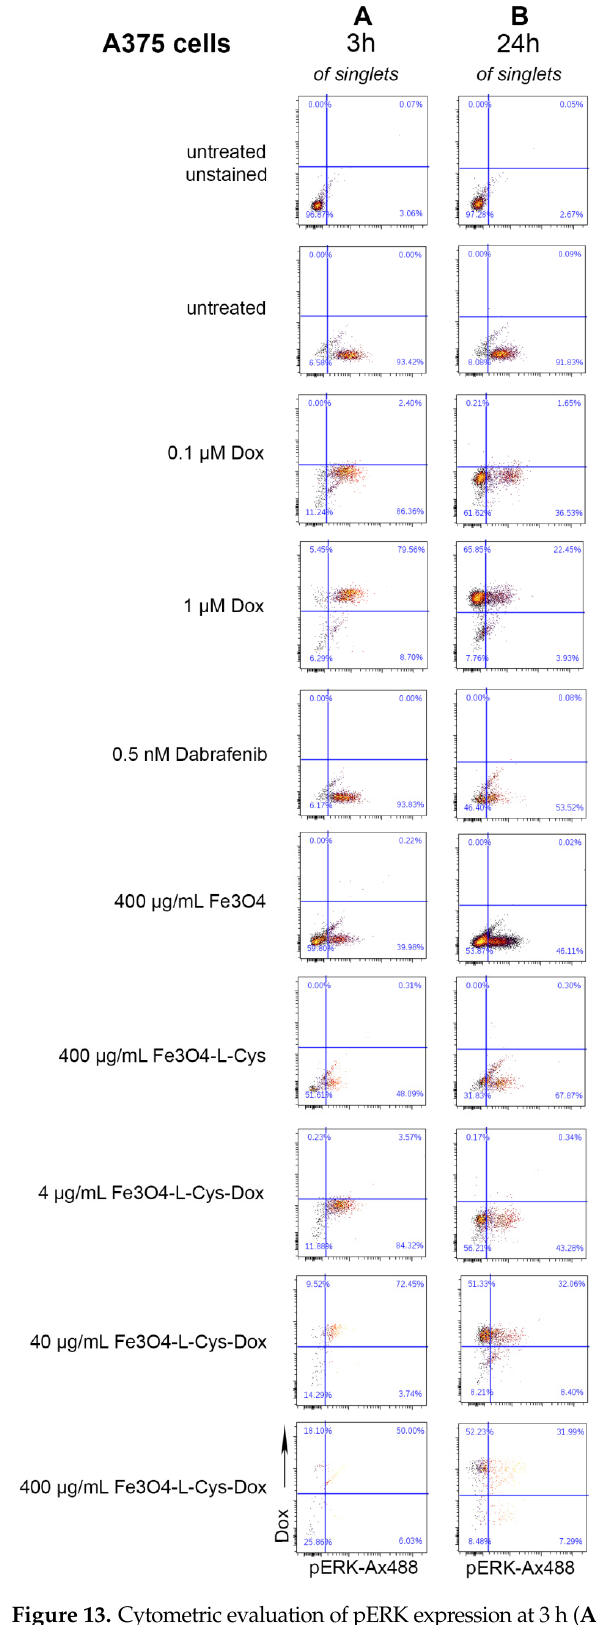
Figure 13. Cytometric evaluation of pERK expression at 3 h ( A ) and 24 h ( B ) after incubation of A375 cells with nanoparticles or free Dox. Phosphorylated ERK was detected on the FITC channel, upon labeling with Alexa Fluor 488-conjugated secondary antibodies, and Dox on the PerCP-Cy5.5